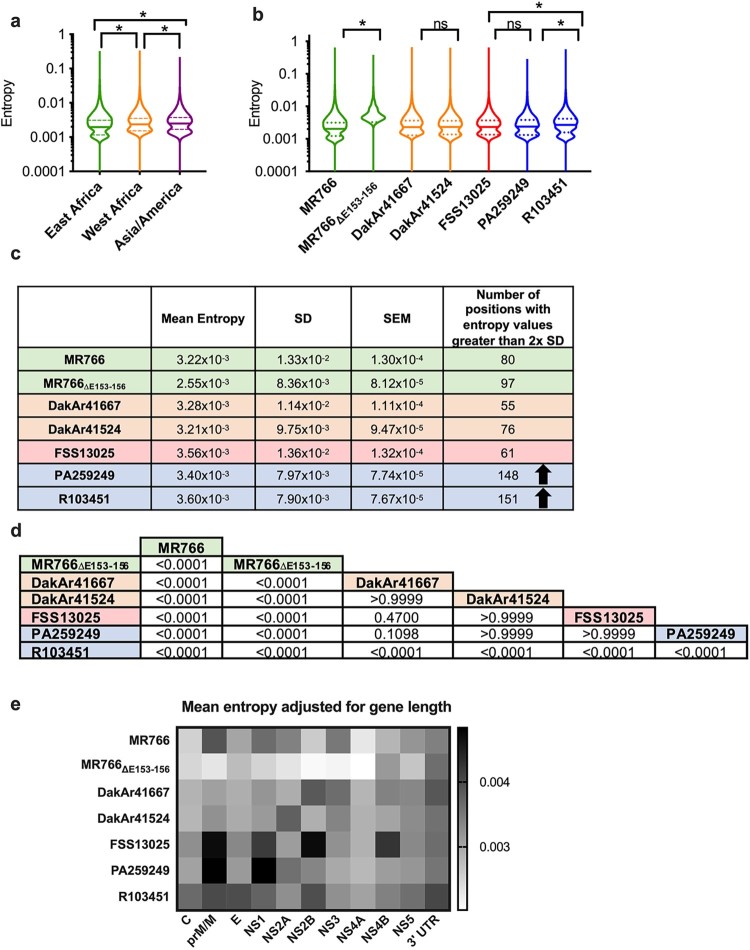
Shannon entropy analysis shows inter- and intra-lineage genetic diversity relationships. The mean Shannon entropy calculated from positions 107-10,700 from two biological replicates of each strain for the East Africa (n = 4), West Africa (n = 4), and Asia/America (n = 6) lineages (A) or by strain (each, n = 2) (B) is shown as violin plots; solid lines: median, dashed lines: interquartile range, statistics determined using Kruskal-Wallis with Dunn’s post-test. C) Mean entropy values for each strain (n = 2) with standard error of the mean (SEM) and standard deviation (SD). The number of positions with entropy values greater than two times the SD are shown; arrows denote that strains PA259249 and R103451 contain more high entropy positions. D) Statistical analysis (Kruskal-Wallis with Dunn’s post-test) of mean genomic Shannon entropy comparing (n = 2) of each strain. E). Relative diversity heat map shows the mean Shannon entropy of each gene region relative to each gene length.